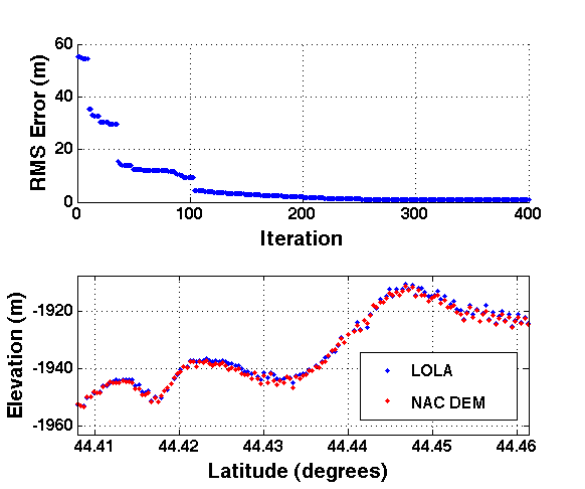
Figure 5. Output of registration program identifying the improvement in the RMS error and a partition of the final